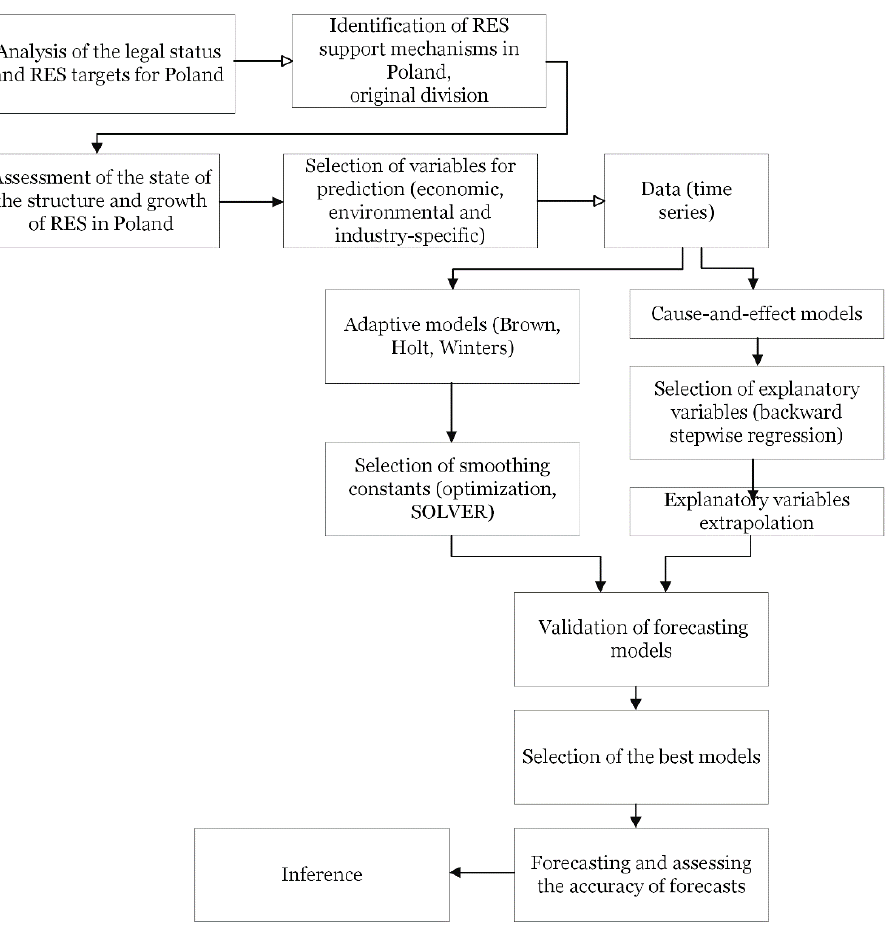
Figure 2. Diagram of the test procedure used to verify the hypothesis. Source: own study.